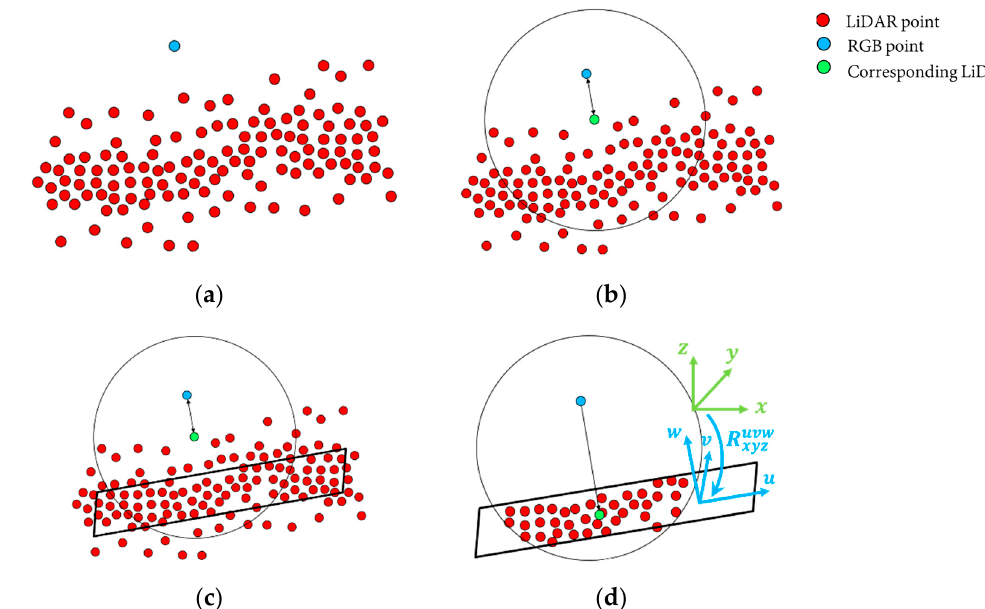
Figure 11. Schematic illustration of deriving the corresponding point for an image-based 3D point from a LiDAR-based point cloud: ( a ) image-based 3D point (blue) and LiDAR points (red), ( b ) closest LiDAR point (green) and corresponding spherical region for extracting neighboring points, ( c ) retained neighboring points within spherical neighborhood and corresponding best-fitting plane, and ( d ) 3D points retained through iterative plane fitting and the projection of the image point (blue) on the best-fitting plane (green) to derive the corresponding LiDAR point.